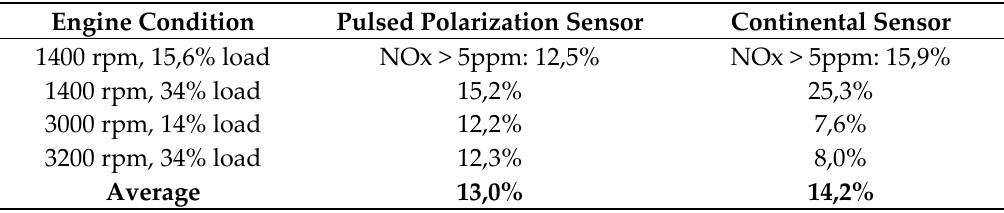
Figure 4. Correlation of the response of a sensor in pulsed polarization moded calibrated to NOx to the concentrations provided by the NOx exhaust gas analyzer. Table 1. Comparison of the relative measurement error for NOx detection of a pulsed polarization sensor and a commercial Continental NOx sensor at different engine